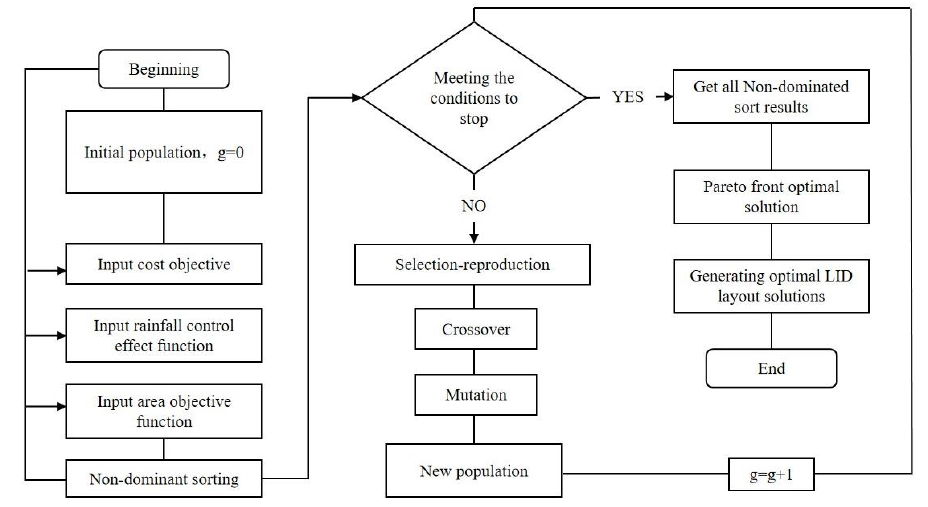
Figure 6. Genetic algorithm optimization flow chart.